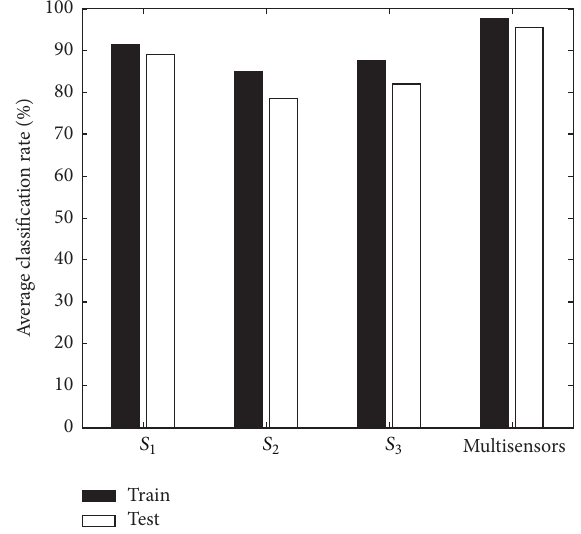
Figure 7: Classification rate of individual sensor and